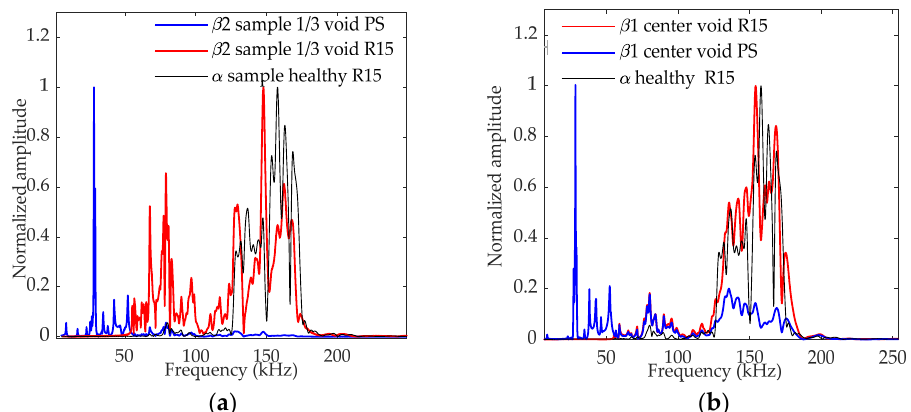
Figure 10. FFT of the simulated signals recorded by the R15 sensor or by the perfect sensor (PS), at sensor location 2: ( a ) for the β 2 sample; ( b ) for the β 1 sample. The curve obtained for the α sample is also superimposed.